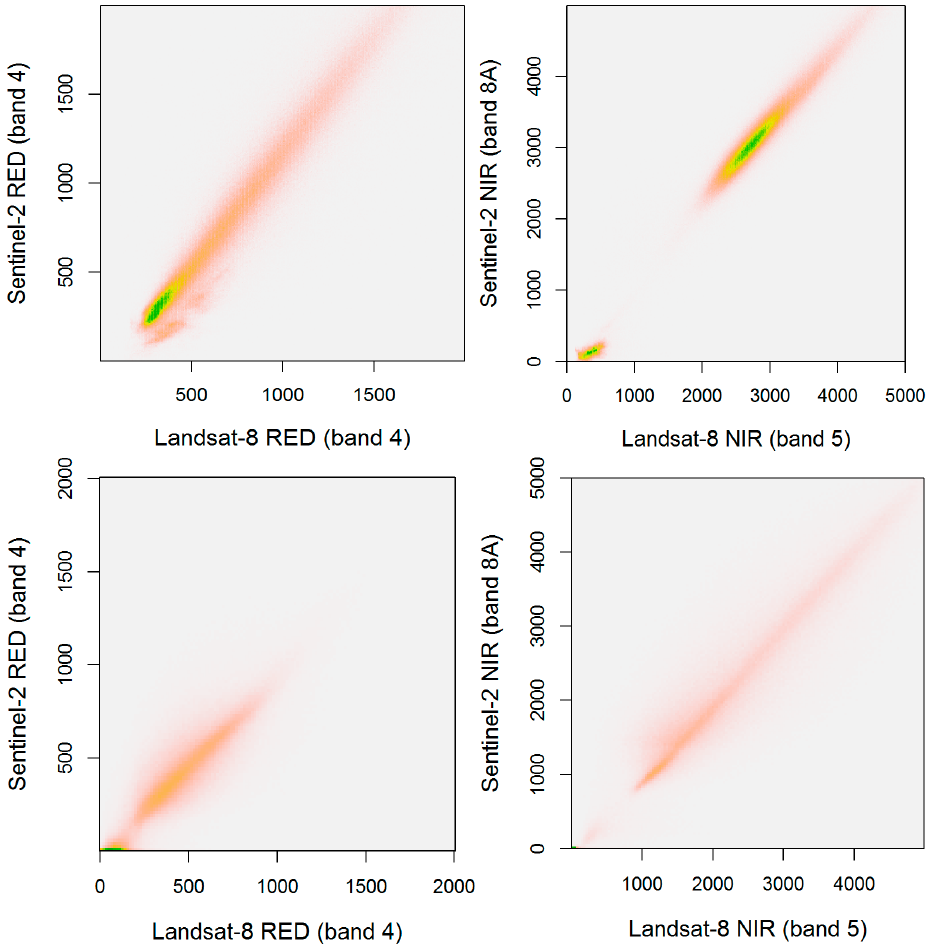
Figure 4. Scatterplots between BoA Landsat-8 and Sentinel-2 reflectance in red and near-infrared for two test sites (top row: Greece, 8 August 2015 tile 34SEH; bottom row: Austria, 31 December 2015, tile 33UUP). The reflectance from Sentinel-2 at 10 m spatial resolution was averaged within a buffer of 30 m to match the pixel size of Landsat-8. BoA reflectance values are scaled by 10,000. Table 2. Contemporaneous Landsat-8 and Sentinel-2 acquisitions used for comparison. For Greece, considering the six homologue bands, results show a R 2 of 0.96 and RMSE of 0.03 reflectance units. For Austria, results show a R 2 of 0.91 and RMSE of